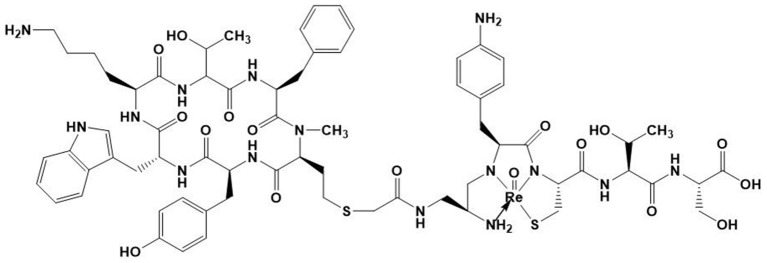
Structure of 188ReO-P2045.